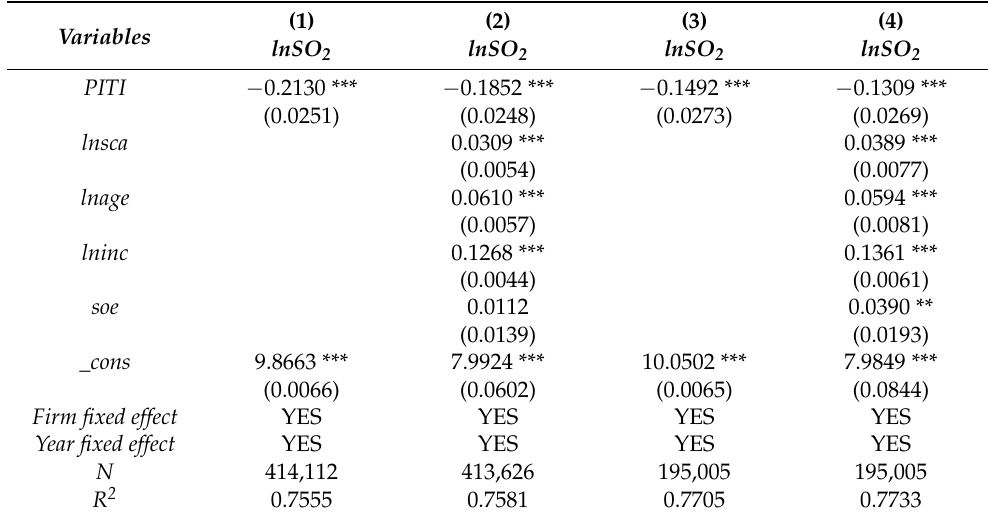
Table 3. Enterprises pollution emissions effect of environmental information